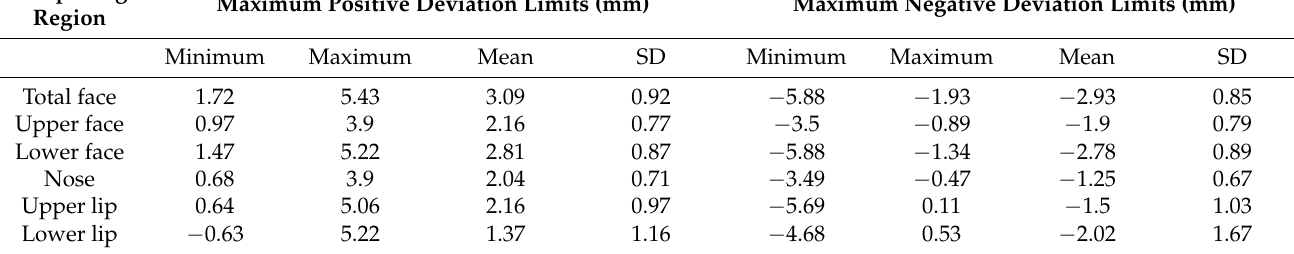
Table 4. Descriptive statistics of the maximum positive and negative deviation in the morphological regions. Morphological